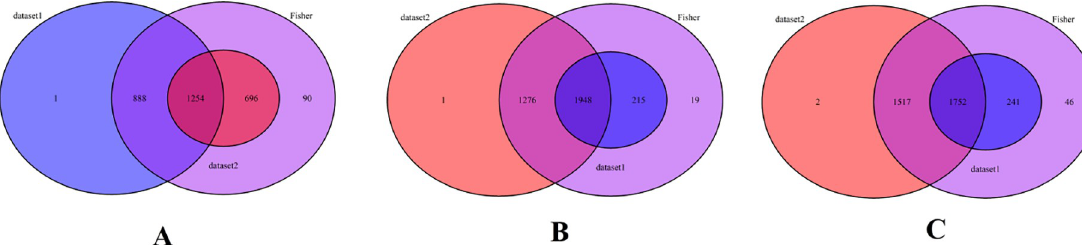
Fig 2. Identified meta genes in two data sets at logarithmic (A), transition (B) and production peak (C) phases after the transition from autotrophic to heterotrophic growth